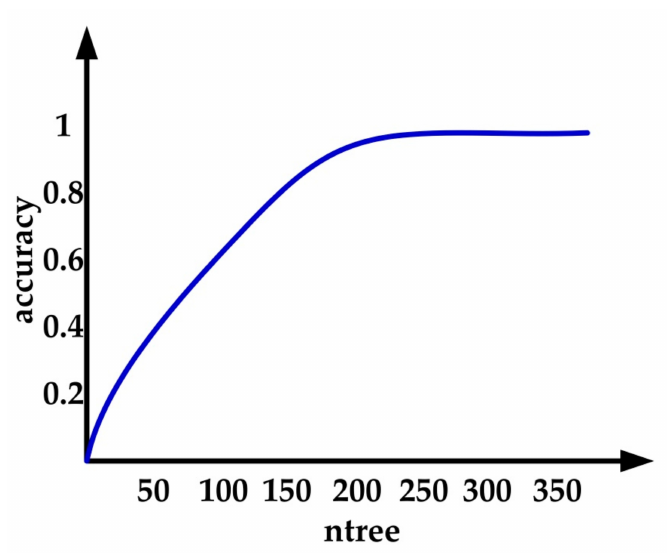
Figure 4. The classification accuracy of di ff erent number of trees in the forest ( ntree) parameters.